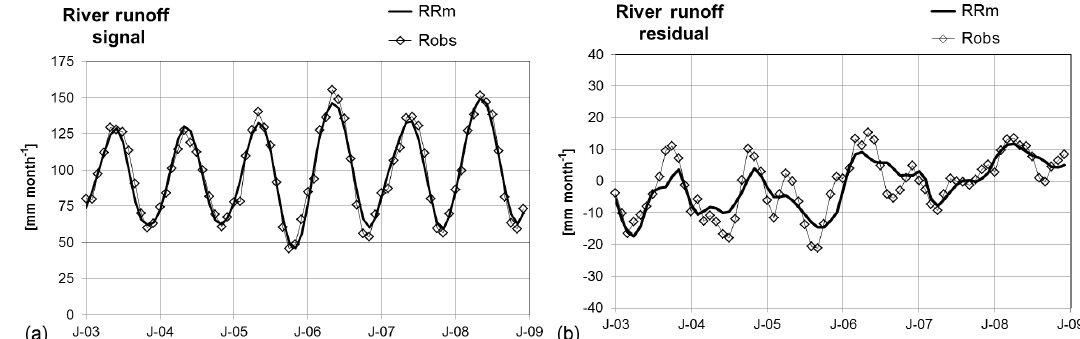
Figure 8. Time series of river runoff R R m for the Amazon and optimization versus GRACE for the signal (a) for the residual (b) .